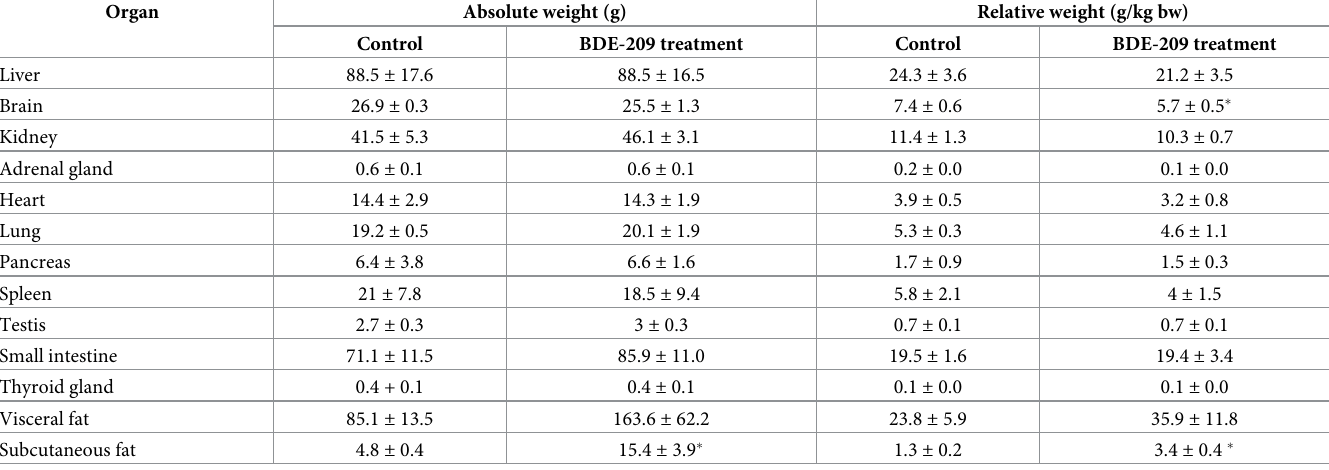
Table 3. Absolute and relative organ weights (mean ± SD) of the control cats and cats treated with BDE-209 ( � : Significant differences between two groups, P <